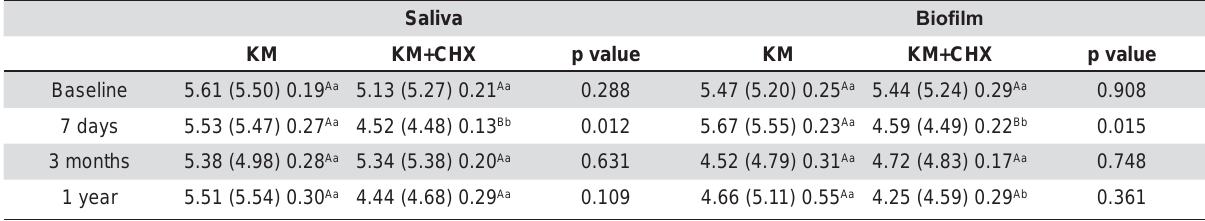
(CFU+1)) before (baseline) and after 10